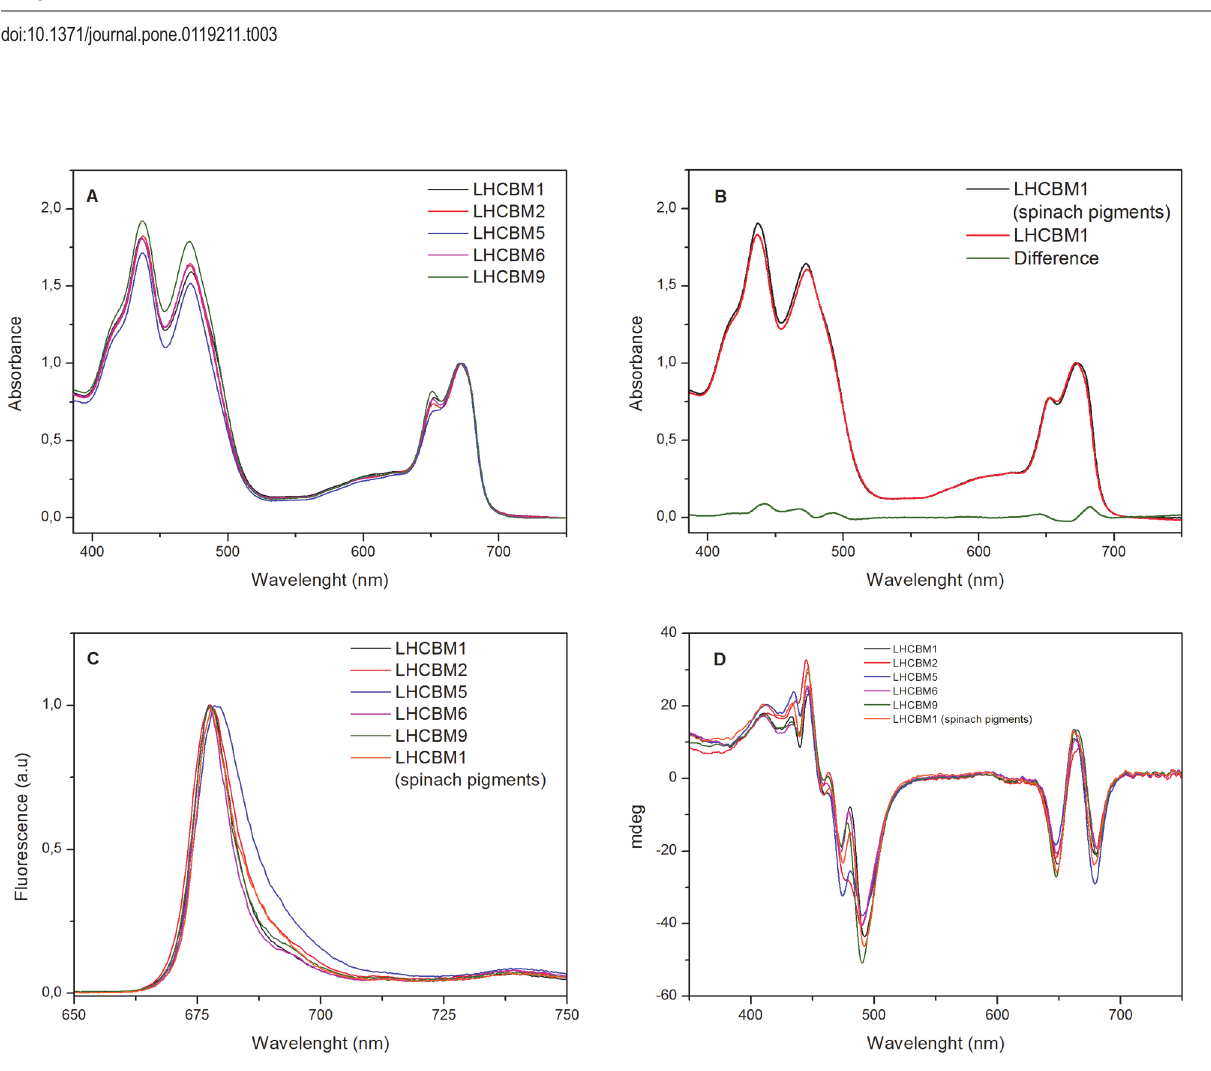
The amplitudes (A i ) of the different lifetimes (t i ) to the fl uorescence decay components, and the average fl uorescence lifetime (t ave ) of the samples are given.